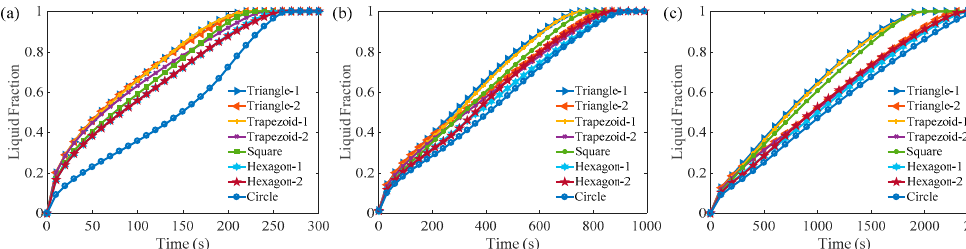
Figure 6. Temporal evolutions of the profiles of liquid fraction in the triangular, trapezoidal, square, hexagonal, and circular cells ( AR = 1.0) at ( a ) Ra = 3.095 × 10 5 ; ( b ) Ra = 4.83 × 10 6 ; ( c ) Ra = 3.87 × 10 7 .